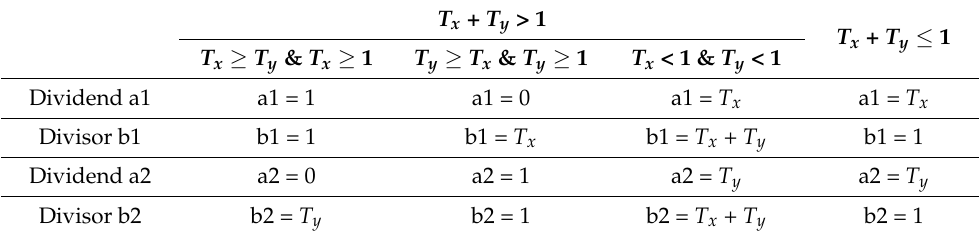
Table 1. Overmodulation input data allocation